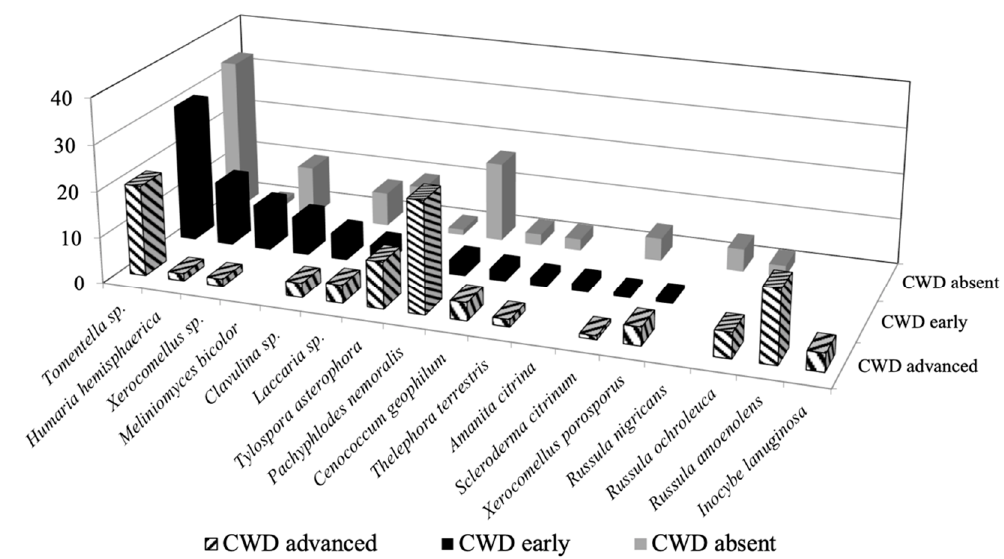
Figure 3. Relative abundance (%) of each mycorrhizal fungal taxa associated with Q. robur trees in the three study sites, characterized by the absence of coarse woody debris (CWD absent ) or coarse woody debris in the early (CWD early ) or advanced (CWD advanced ) stages of wood decay. The ECM community in CWD absent was dominated by the medium distance smooth (50.6%,